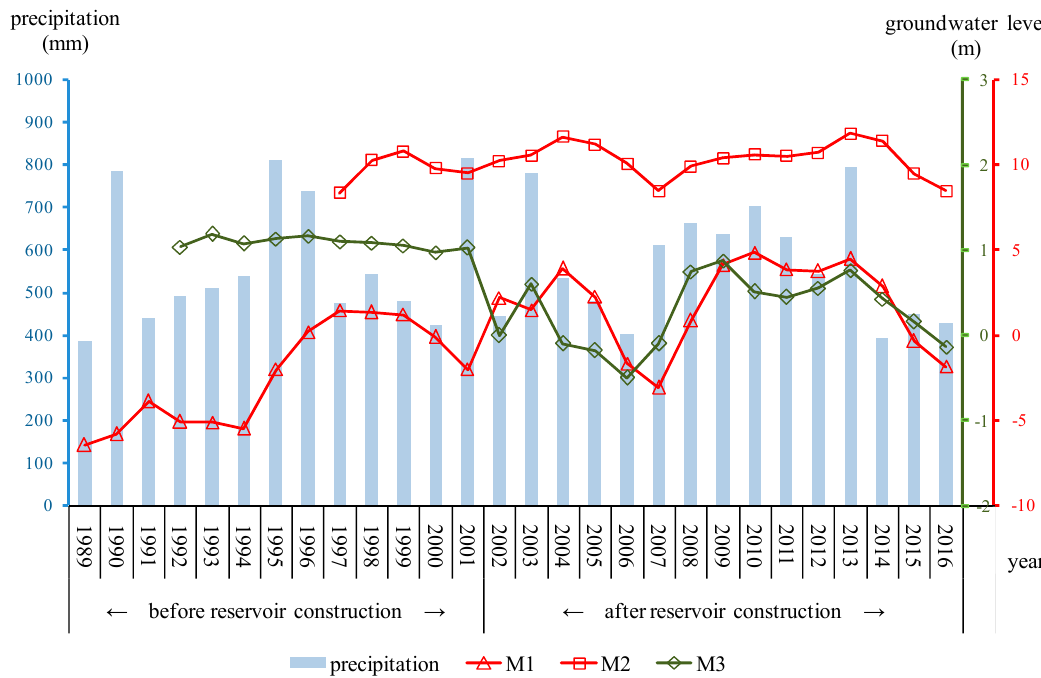
Figure 6. Relationship between annual precipitation and average annual groundwater level.